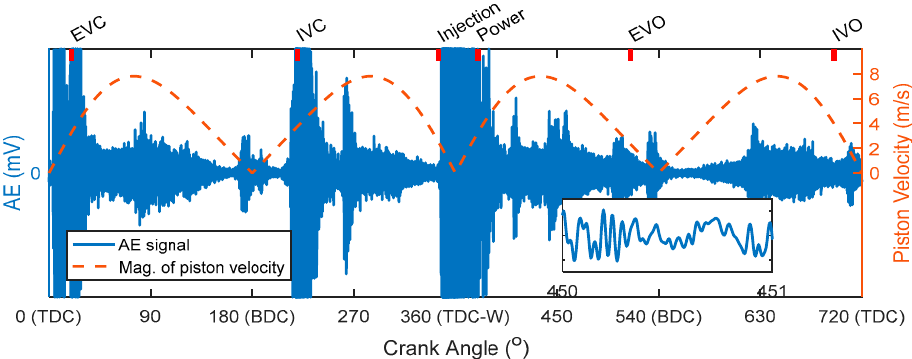
Figure 5. AE raw signals in a working